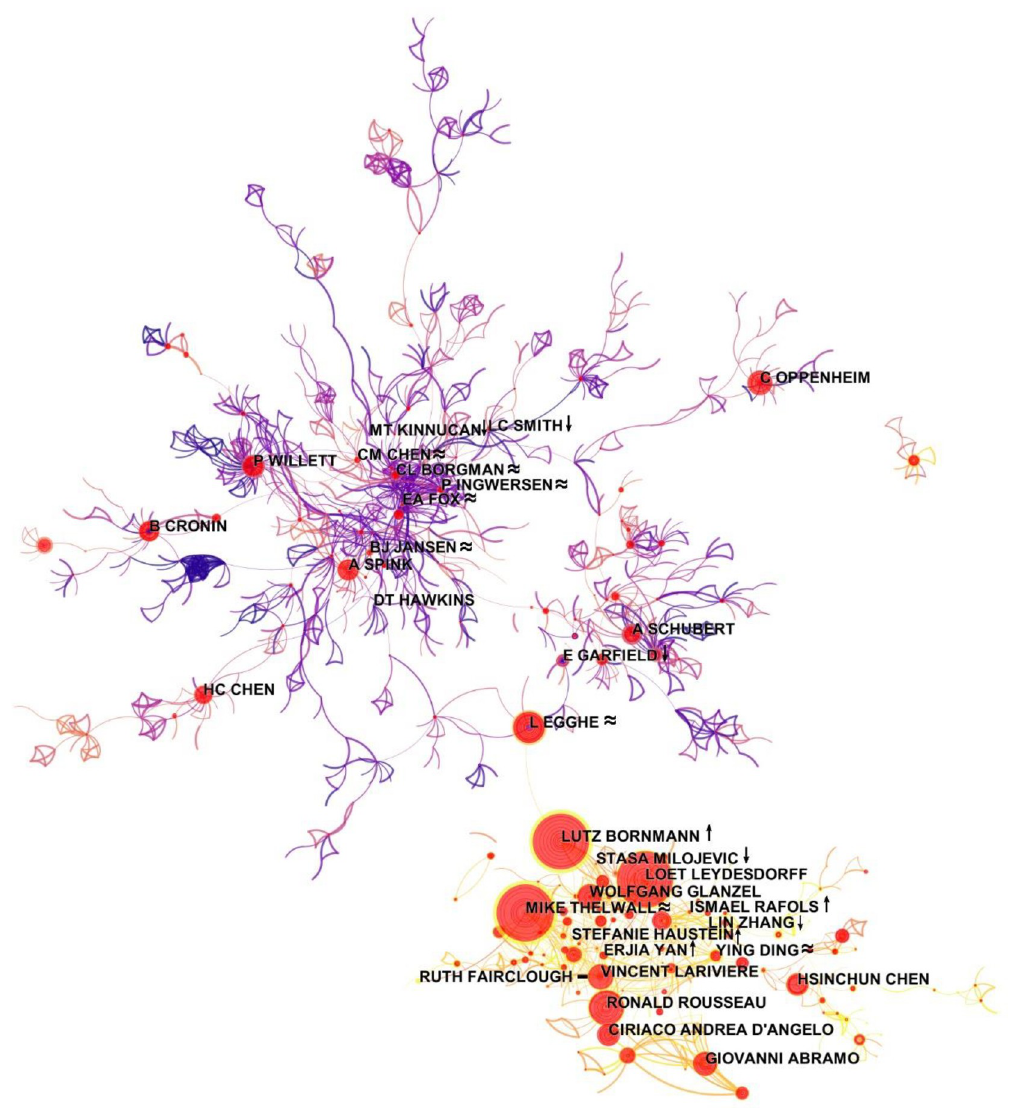
Fig 12. Information science co-authorship network 1979–2018 (“ " ” increasing, “ # ” decreasing, “ � ” sustained, and “ − ” transient). Table 5 lists the burst rates of different types of researchers included in Table 3. The burst rate of a document (or researcher) can reflect the burst of citation of this document (or researcher) within a certain specialty in a certain period. A stronger burst shows higher atten- tion to this research topic (or researcher). We found that all transient researchers have zero burst rates. The researchers of the increasing type, decreasing type, and sustained type had high burst rates. Moreover, we used four types as Type A, Type B, Type C, and Type D to rep- resent increasing, decreasing, sustained, and transient, respectively. 7 of the top 10 Type A researchers had high burst rates, while 6 of the top 10 Type B researchers had high burst rates, and 9 of the top 10 Type C researchers had high burst rates, suggesting that sustained Δ M val- ues are more likely to correlate with strong bursts. Finally, the average burst rates of different types of researchers are: Type C > Type A > Type B > Type D. From the perspective of the